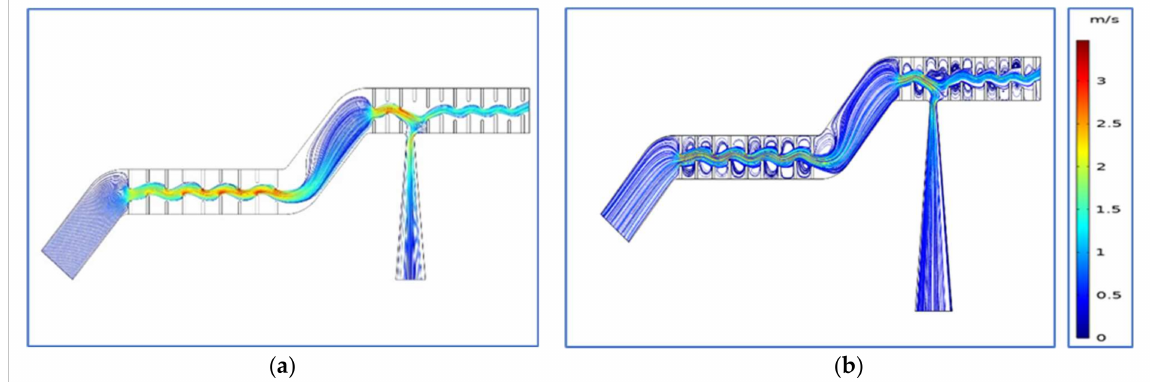
Figure 13. Velocity streamline in cilia wall microchip: ( a ) 100 streamlines; ( b ) 500